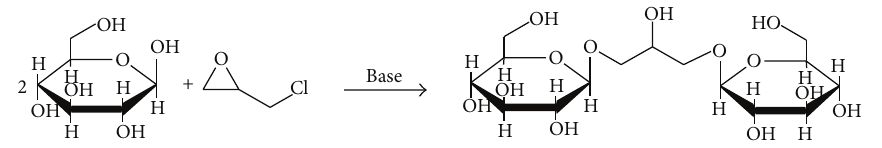
Scheme 1: Synthesis of trimethylsilyl glucoside